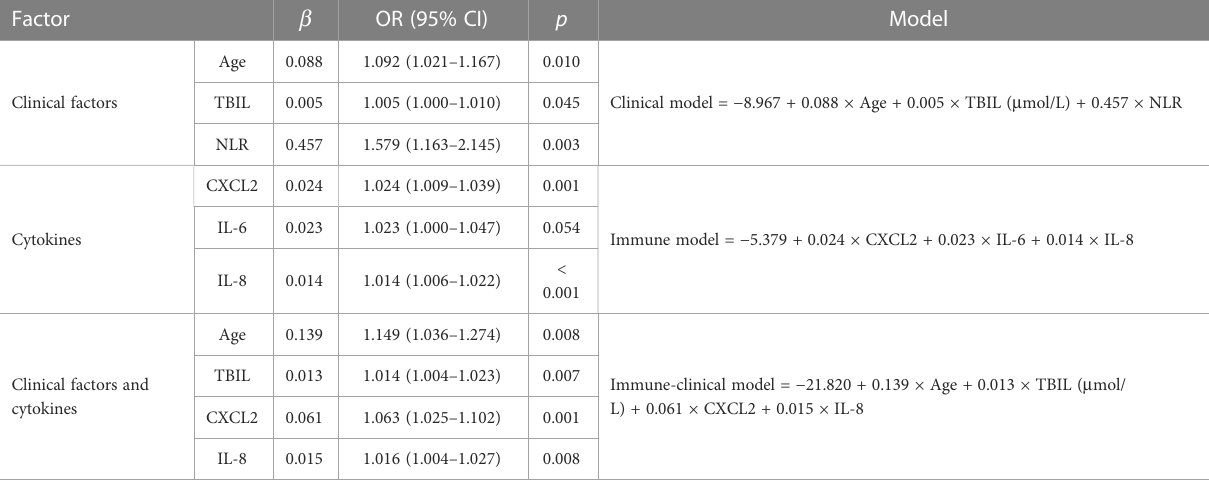
TABLE 3 Multivariate logistic analyses of the cytokines/chemokines and the clinical factors. Factor b OR (95% CI) p Model